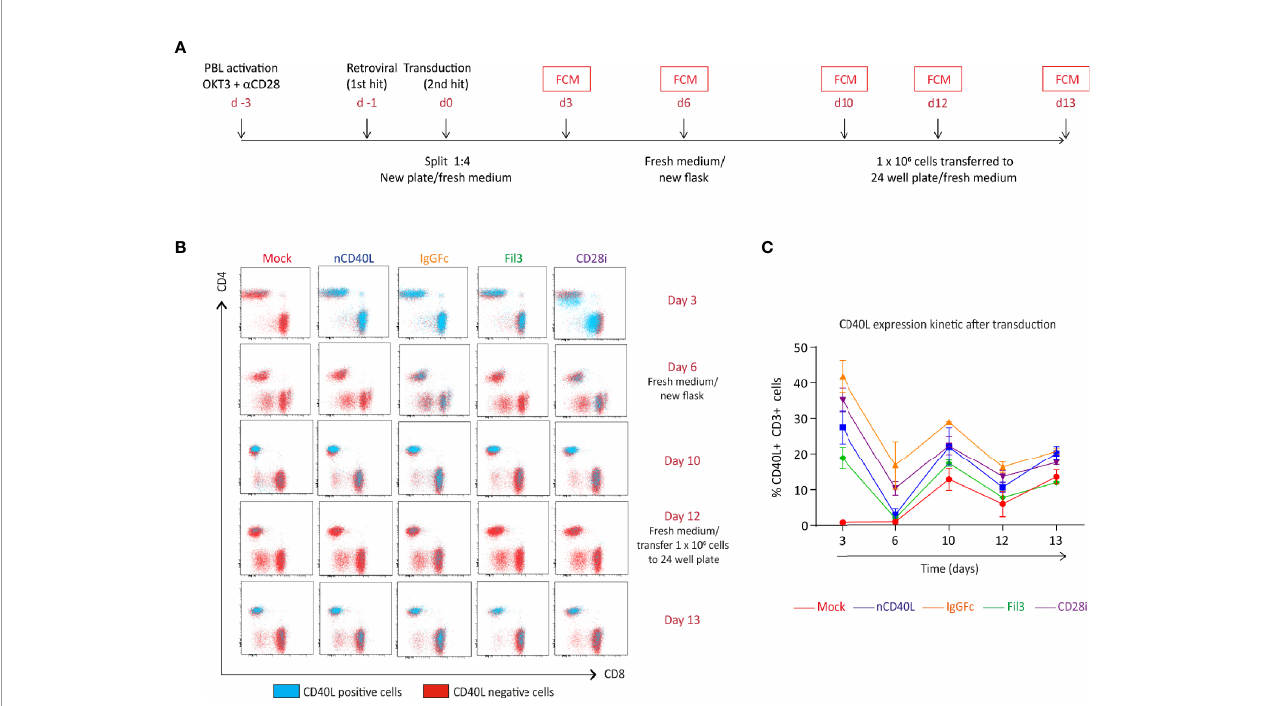
FIGURE 4 | CD40L:CD28 CSP expression kinetic in T cells is modulated by medium replacement. Human primary T cells were retrovirally transduced with the native CD40L sequence or the CSP constructs and expanded for 12 days. Cells were transferred to a new fl ask or plate with fresh medium/100 U/ml IL-2 on day 6 and 12. (A) Timeline describing the transduction steps and expansion of human primary T cells. (B) CSP surface expression was measured by fl ow cytometry (FCM) at day 3, 6, 10, 12 and 13 after transduction using CD40L antibody. The CD4 and CD8 cells within the live, single, CD3 + population are depicted in the dot plots and the CD40L-positive (blue dots) and CD40L-negative (red dots) are graphically superimposed. Mock-transduced T cells were used as negative control and T cells transduced with the native CD40L (nCD40L) sequence were used as positive reference. (C) Percentage of CD40L-positive T cells at the different time points after transduction. Summary of 2 independent experiments, plus SEM. Mock-transduced T cells (red line) and T cells transduced to express the native CD40L (blue line) were used as reference. T cells transduced with CD40L:IgGFc:CD28 are depicted in orange, those with CD40L:Fil3:CD28 CSP are depicted in green and T cells with CD40L:CD28i CSP are depicted in